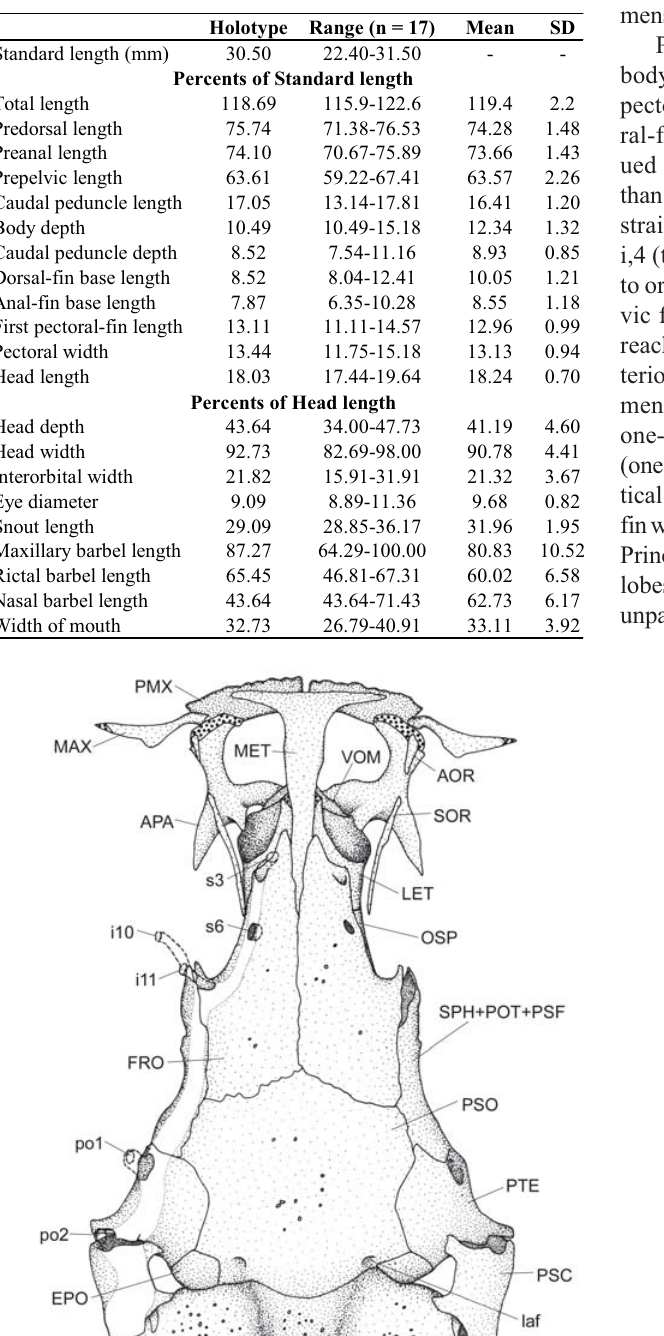
Table 1. Morphometrics of Ituglanis macunaima . Abbreviations: SD, standard deviation; n, number of specimens measured.